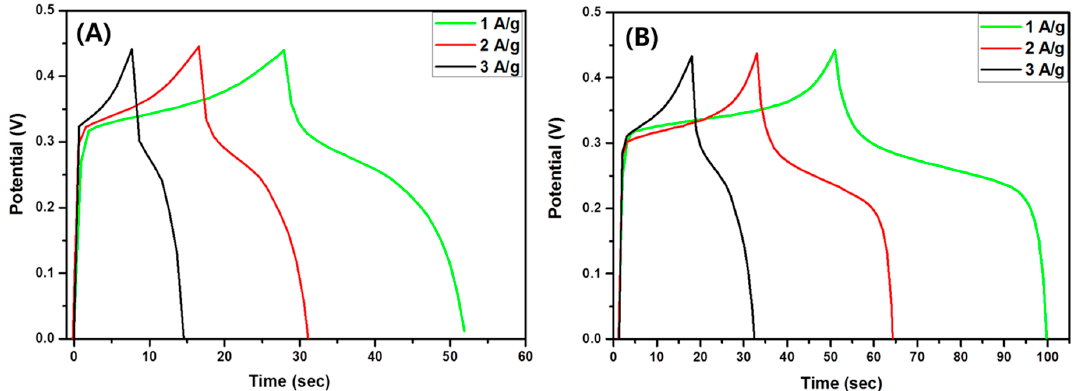
Figure 9. Galvanostatic charge–discharge (GCD) curves of pristine TiO 2 NFs ( A ) and TiO 2 -carbon NFs ( B ) at different current densities.